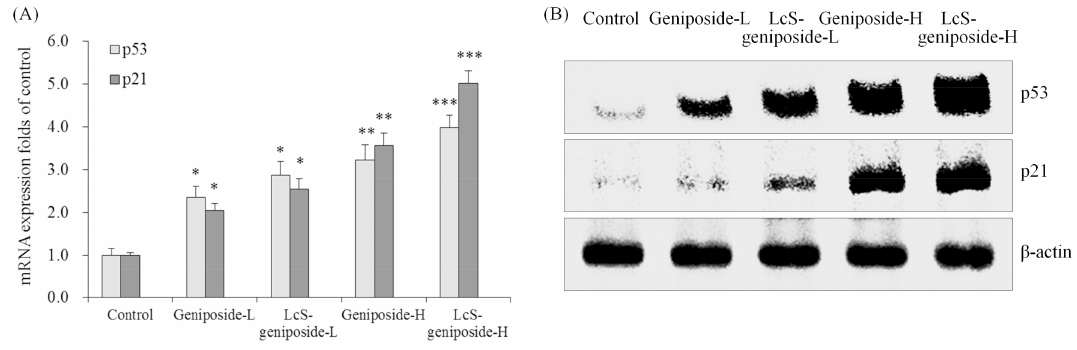
Figure 5. The mRNA ( A ) and protein ( B ) expressions of p53 and p21 in human oral squamous carcinoma HSC-3 cells. * p < 0.05, ** p < 0.01, *** p < 0.001 vs. the control group. Geniposide-L: 25 µ g/mL geniposide; LcS-geniposide-L: 1.0 × 10 6 CFU/mL LcS + 25 µ g/mL geniposide; Geniposide-H: 50 µ g/mL geniposide; LcS-geniposide-H: 1.0 × 10 6 CFU/mL LcS + 50 µ g/mL geniposide.